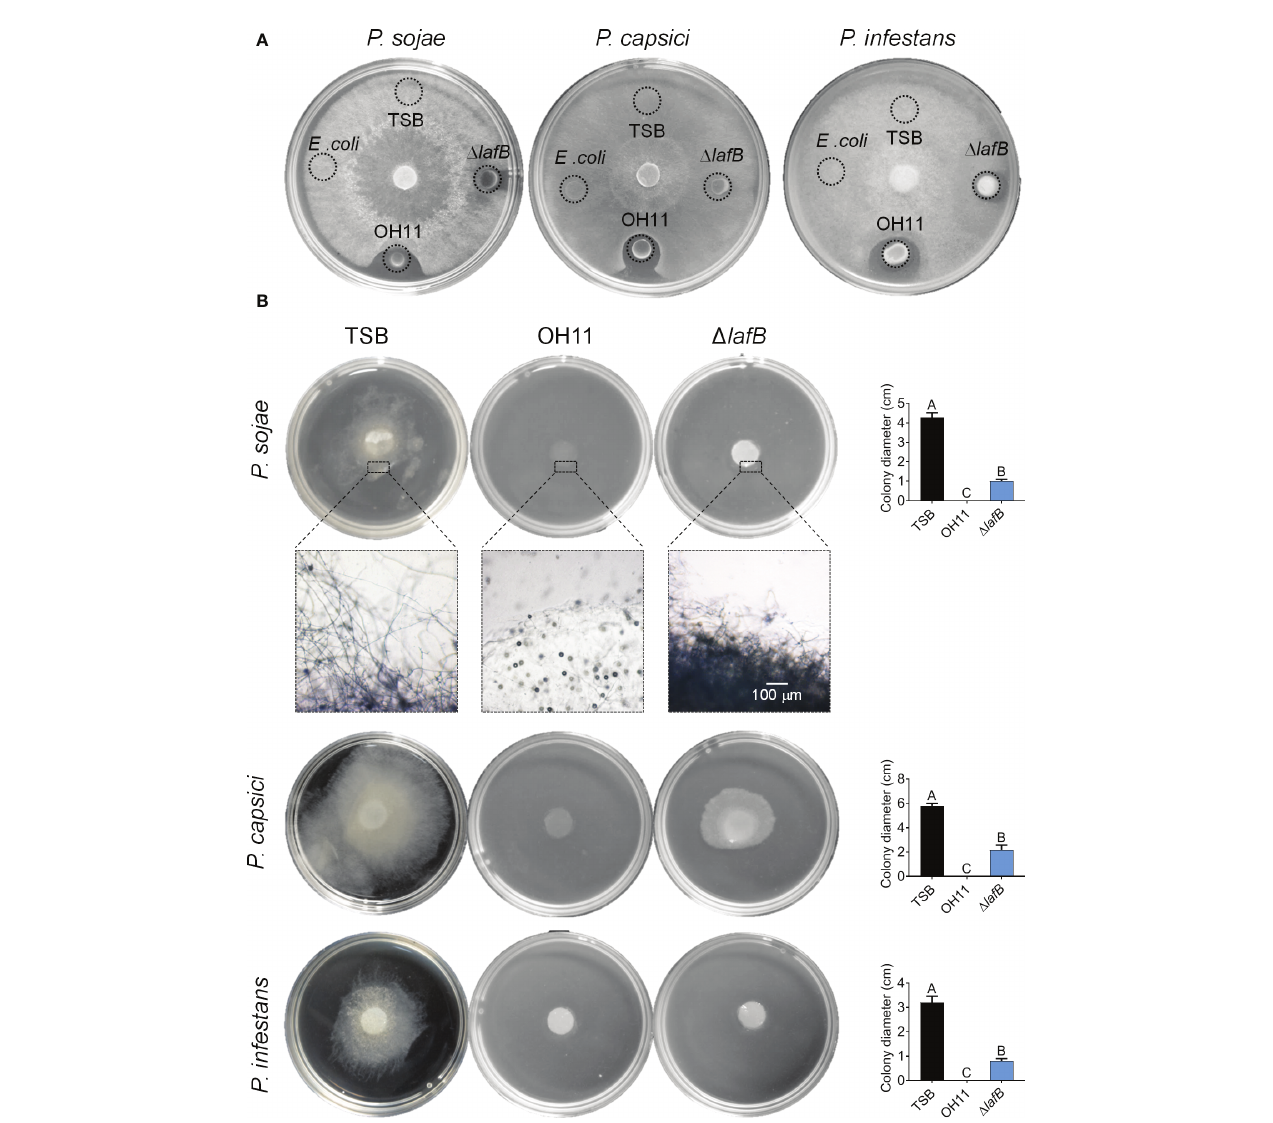
FIGURE 2 L. enzymogenes OH11 inhibited mycelial growth of the Phytophthora pathogens. (A) Compared with wild-type OH11, the HSAF-de fi cient mutant D lafB had less antagonistic activity against Phytophthora on solid media. lafB is a key gene for HSAF biosynthesis. (B) Wild-type OH11 degraded mycelia of Phytophthora. Phytophthora hyphal plugs were cultured in liquid media mixed with TSB, OH11, and D lafB , respectively. OH11 completely inhibited Phytophthora mycelial growth and degraded the mycelia in hyphal plugs, while D lafB inhibited mycelial growth of Phytophthora . Three replicates of each sample were analyzed using a one-way ANOVA